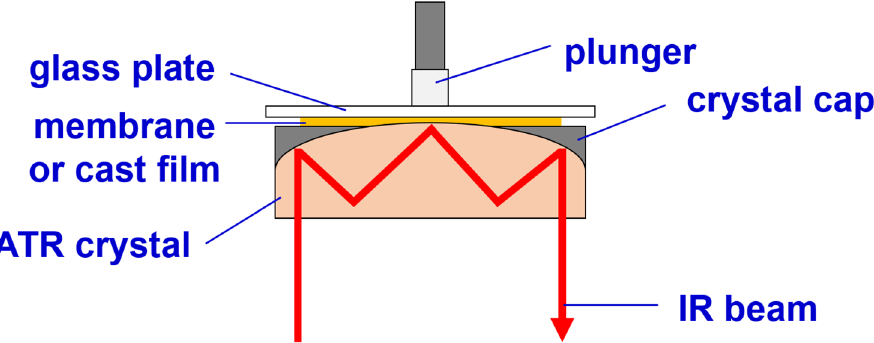
Figure 3. The setup for performing FTIR/ATR analysis at the surface of a membrane or a cast film. With the IR spectra obtained with the FTIR/ATR analyses at different times during